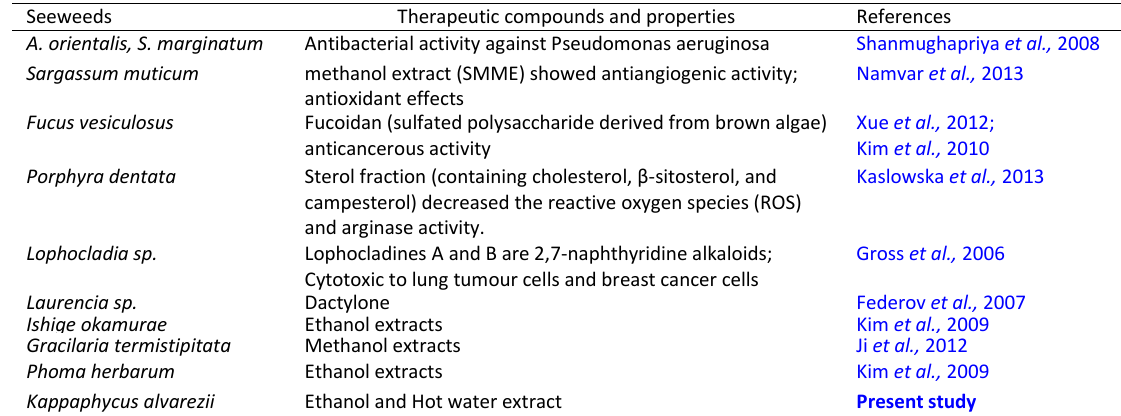
Table 7: Various seaweeds and its therapeutic properties Seeweeds